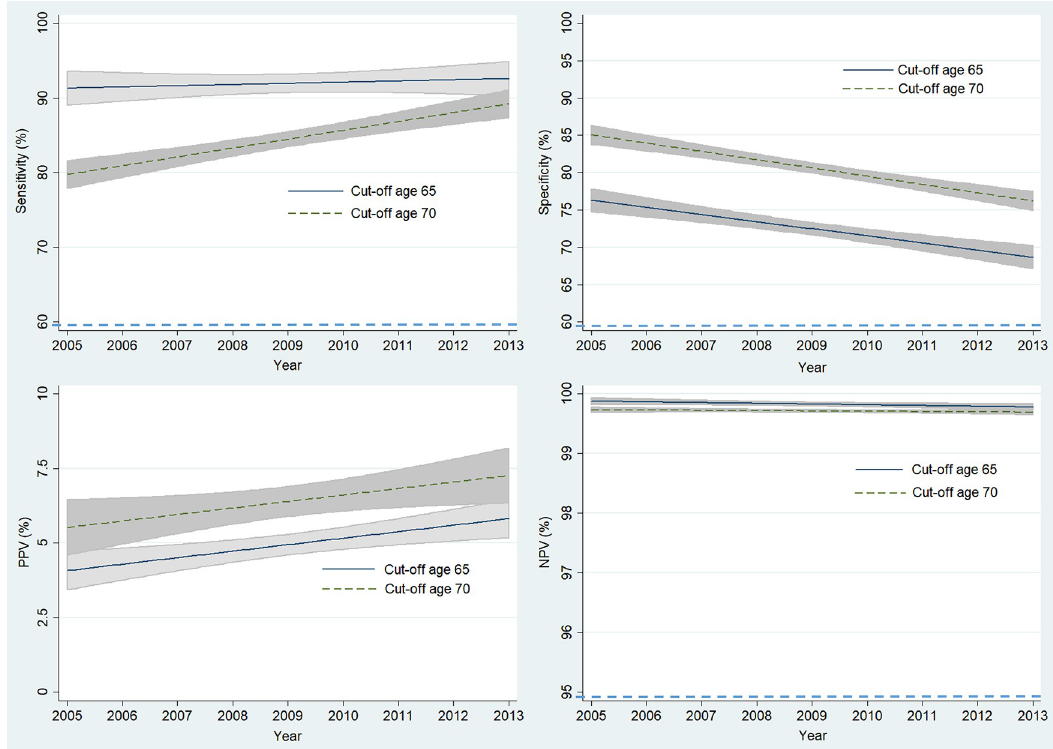
Fig 3. Annual trend in sensitivity, specificity, PPV and NPV of the current and alternative age thresholds in NHIS-NSC cohort. PPV, positive predictive value; NPV, negative predictive value. The 95% confidence intervals for each point are shown as shaded